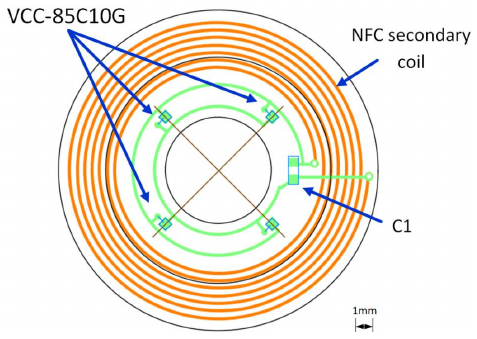
Figure 12. Option with remote computation (VCC-85C10G: VCSEL).